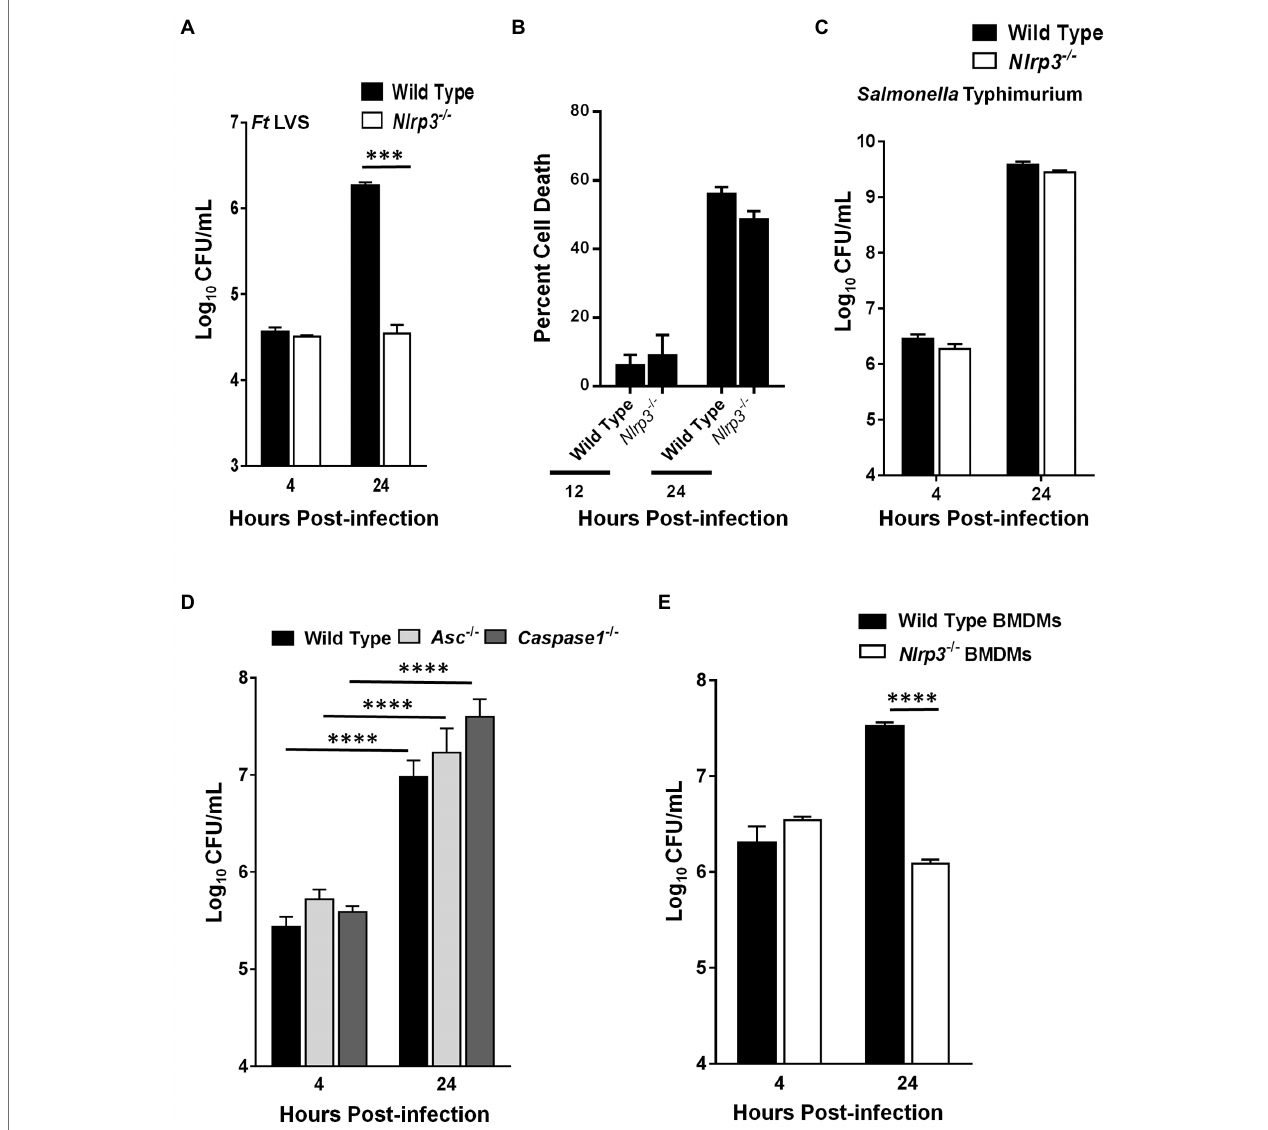
FIGURE 3 | Francisella tularensis ( Ft ) LVS fails to replicate in Nlrp3 − / − macrophages. Wild-type and Nlrp3 − / − macrophages (A,B) were infected with 100 MOI of Ft LVS or (C) with 100 MOI of Salmonella Typhimurium. (A,C) The macrophages were lysed after 4 and 24 h of infection, diluted 10-fold and plated on MH-chocolate agar plates for the enumeration of bacterial numbers. (B) Percent cell death was determined by LDH release assay 12 and 24 h post-infection. (D) Wild type, Asc − / − or the Caspase1 − / − macrophages were infected with 100 MOI of Ft LVS and bacteria were quantitated at 4 and 24 h post-infection. (E) Wild-type and Nlrp3 − / − primary bone marrow-derived macrophages (BMDMs) isolated from C57BL/6 mice were infected with 10 MOI of Ft LVS and bacteria were quantitated at 4 and 24 h post-infection. The data are representative of two–three independent experiments each conducted with three biological replicates. The data were analyzed by ANOVA with the Tukey-Kramer test, and a value of p of 0.05 or less was considered significant. *** p < 0.001; **** p <